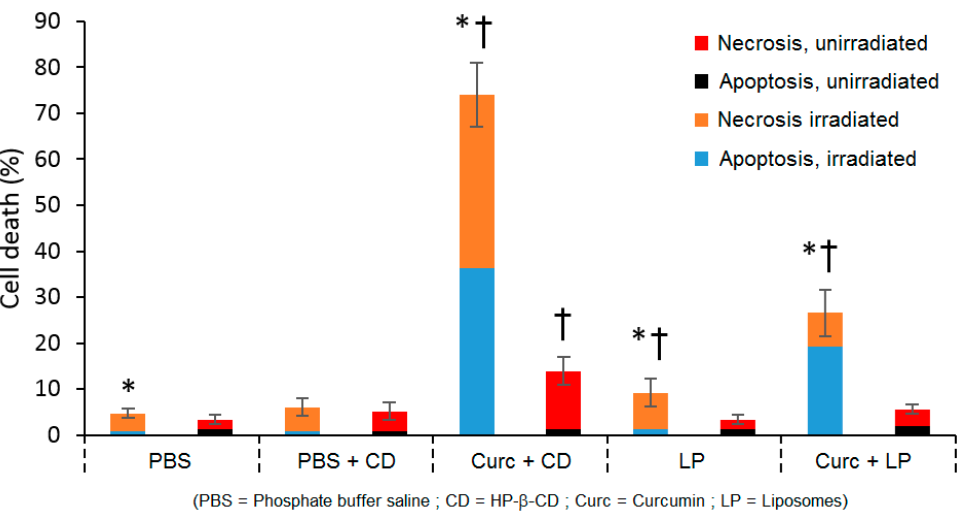
Figure 15. Cytotoxicity expressed as percentage of salivary gland acinar cells SM 10–12 cell death in terms of apoptosis and necrosis assayed by the PI/Hoechst staining and fluorescence technique. The cells were irradiated with blue light of a 6 J/cm 2 beam area or kept for 5 min in the dark in the presence of 13.5 µM natural curcumin in 5% cyclodextrin (CD) or 0.4 µM in 5 µg/mL liposomes (LP). Data are means ± SEM ( n ≥ 6). Significantly different from corresponding unirradiated samples (for phosphate buffered saline (PBS): necrosis only) (*); significantly different from irradiated vehicle in PBS and PBS only (for CD samples: also different from unirradiated vehicle) ( † ); p ≤ 0.05. Adapted from Bruzell; Morisbak; Tonnesen [131].